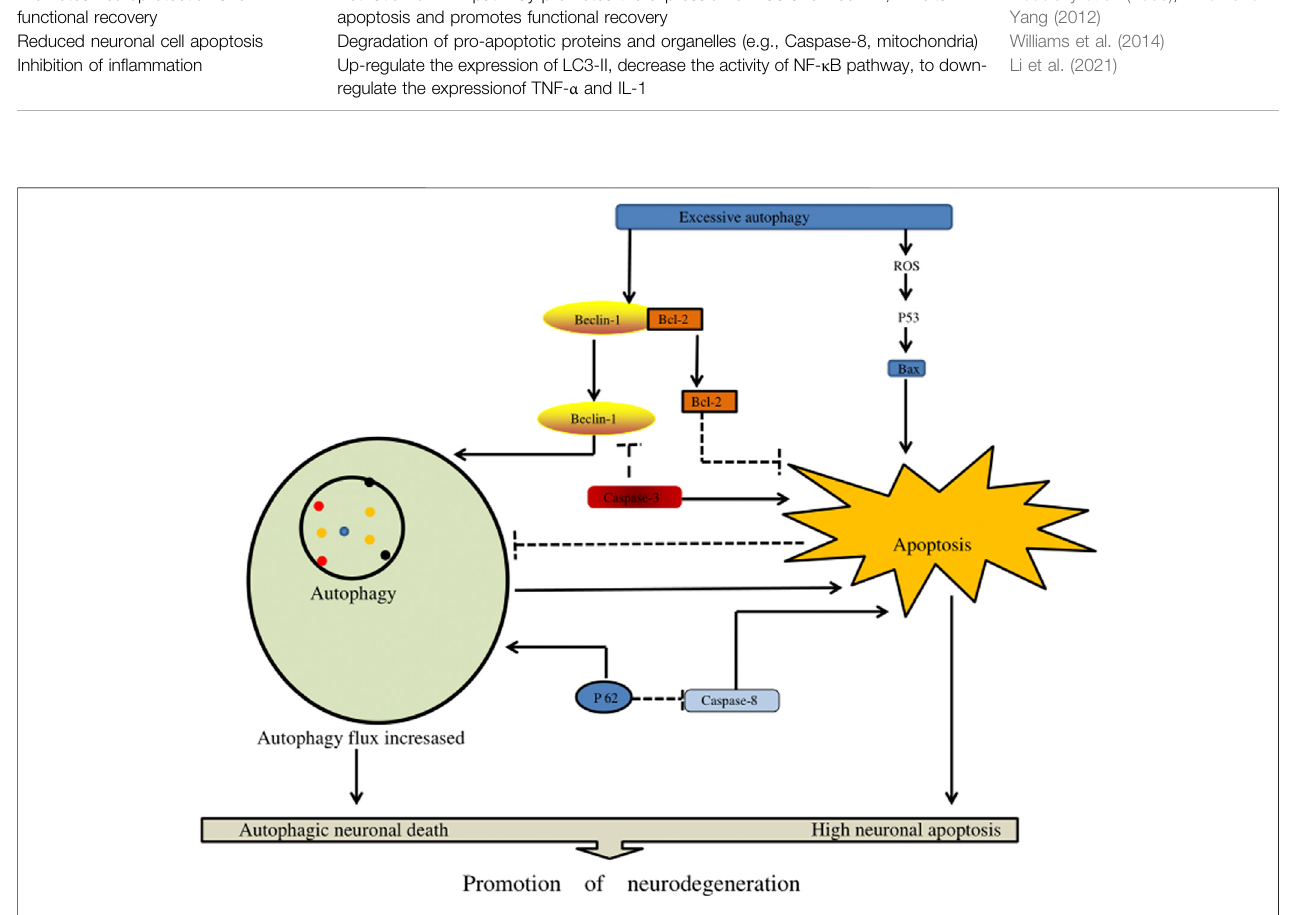
FIGURE 6 | The effect of excessive autophagy on spinal cord injury. Excessive autophagy leads to the separation of Beclin-1 and Bcl-2 and the production of excessive reactive oxygen species in P53 signaling, resulting in the generation of free Bax. In addition, Beclin-1 and P62 can enhance autophagy fl ux, resulting in autophagy death of nerve cells, and enhance apoptotic factors (such as caspase-3, caspase-8, and Bax) to accelerate nerve cell apoptosis.